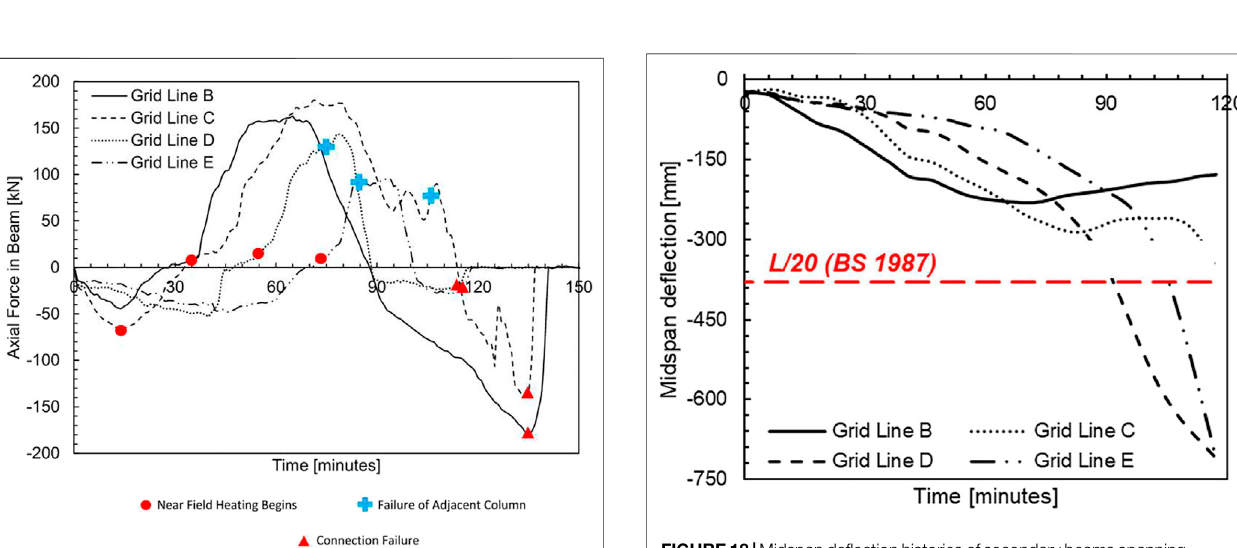
FIGURE18| Midspande fl ectionhistoriesofsecondarybeamsspanning between MRF and gravity columns in Fire Scenario #3.